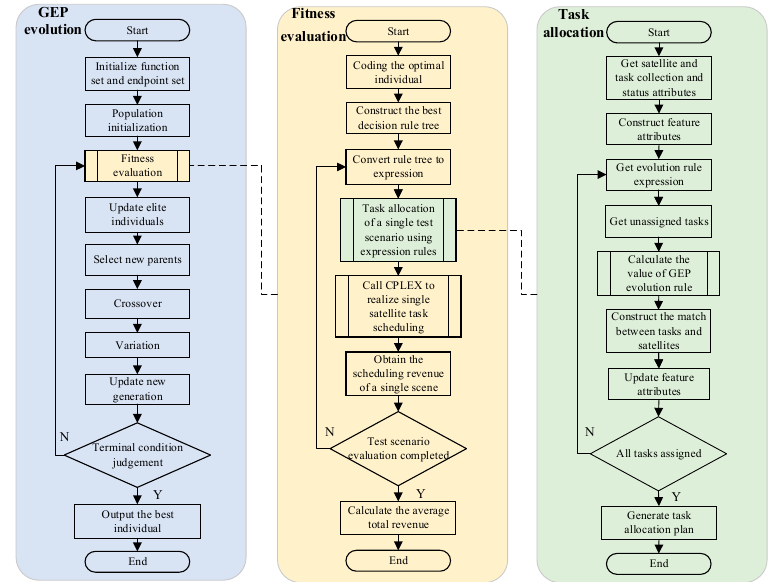
Figure 4. The CHMGEP evolutionary framework.